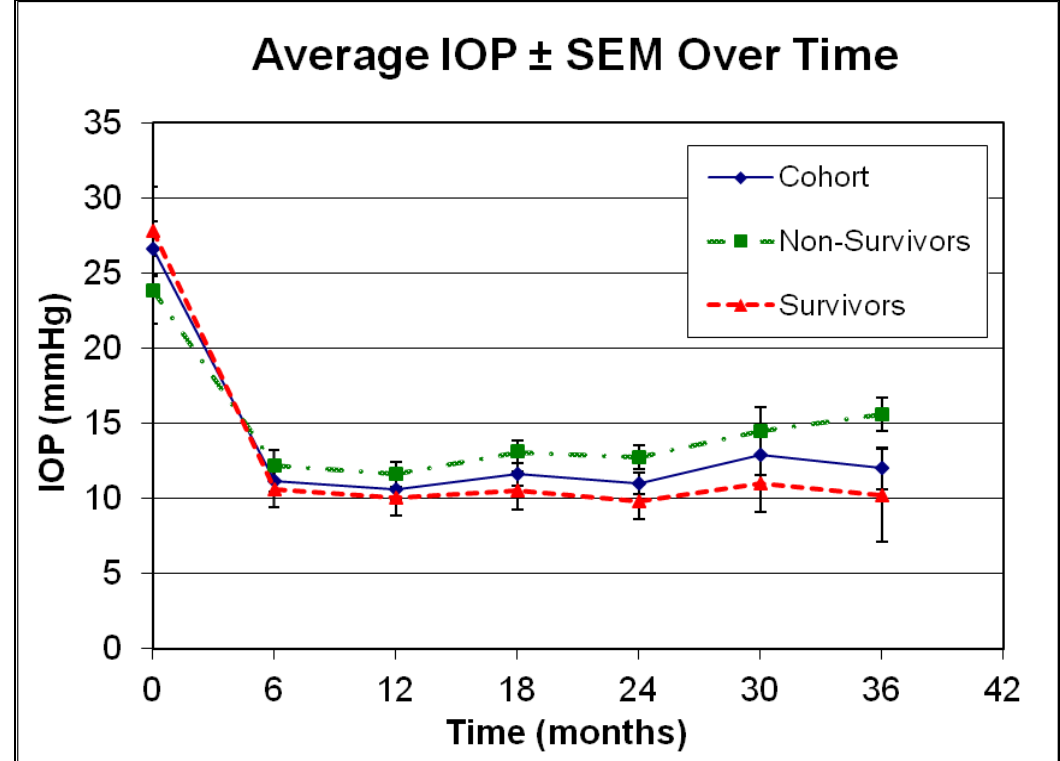
Figure 5. Course of average intraocular pressure (IOP) ± standard error of measurement (SEM) for all patients (cohort), for those who failed by visual function criteria (non-survivors) and for those who successfully maintained visual function (survivors), as outlined in methods. Error bars represent standard error of measurement at respective time-points. IOP differed between survivors and non-survivors significantly at 18 months ( p = 0.04, one tail student ’ s t- test), 24 months ( p = 0.02, one tail student ’ s t- test) and 36 months ( p = 0.03, one tailed student ’ s t- test).